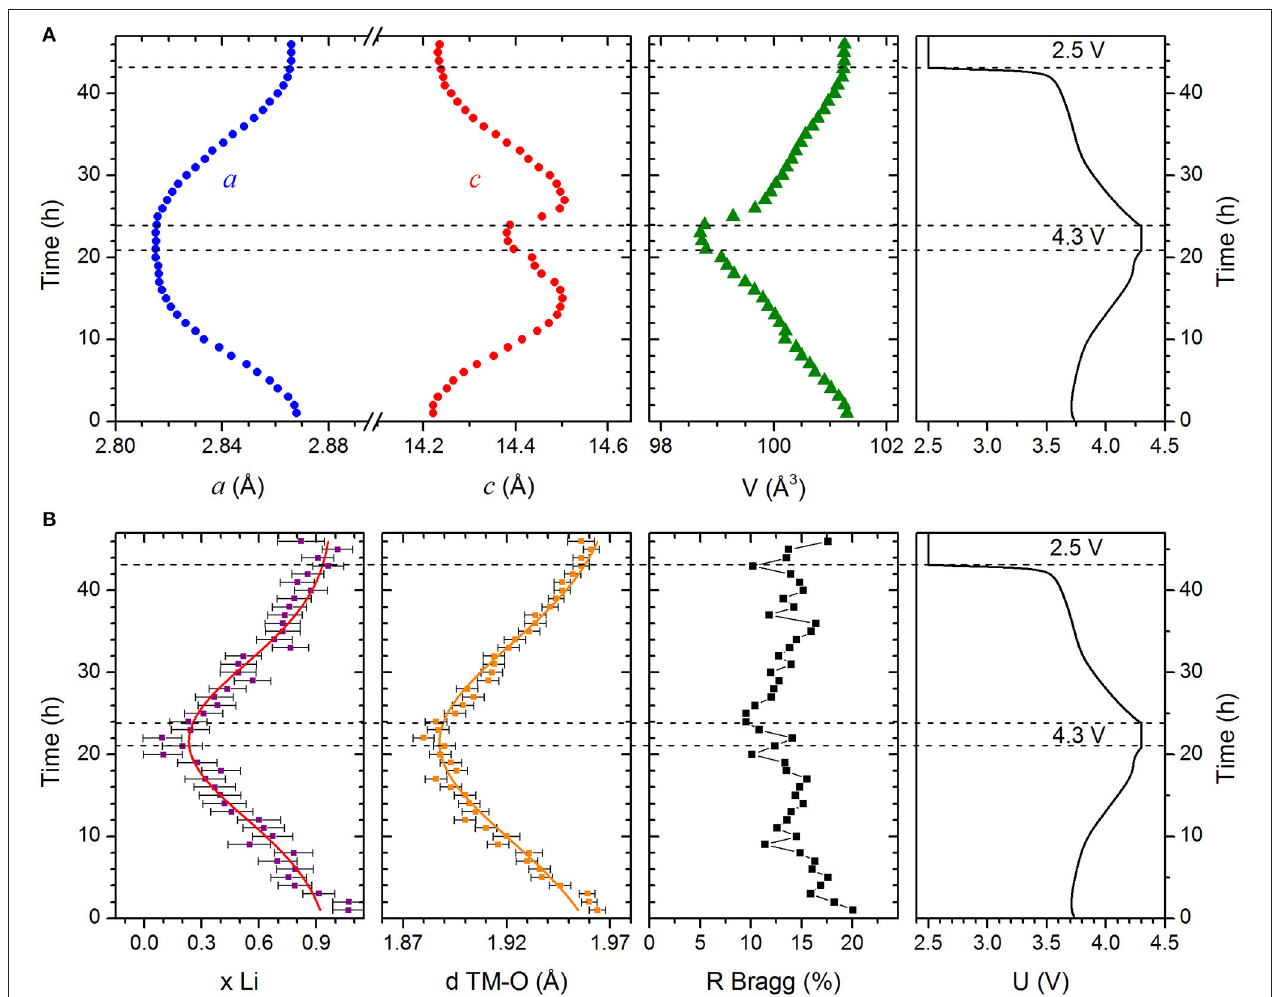
FIGURE 7 | Evolution of the structural parameters of NCM622 determined from the sequential refinement using neutron diffraction data collected during the operando experiments. (A) Unit cell parameters and volume. The errors on these values are smaller than the symbol sizes. (B) Lithium content and the interatomic distance between oxygen and transition metal atoms ( d TM − O ). Solid lines in these panels are guides to eye. The reliability factor, R-Bragg, is indicated for each refinement. The standard deviations of the refined parameters for the refinements done on the background-subtracted data have been corrected to account for the artificial underestimation of the errors, see text for